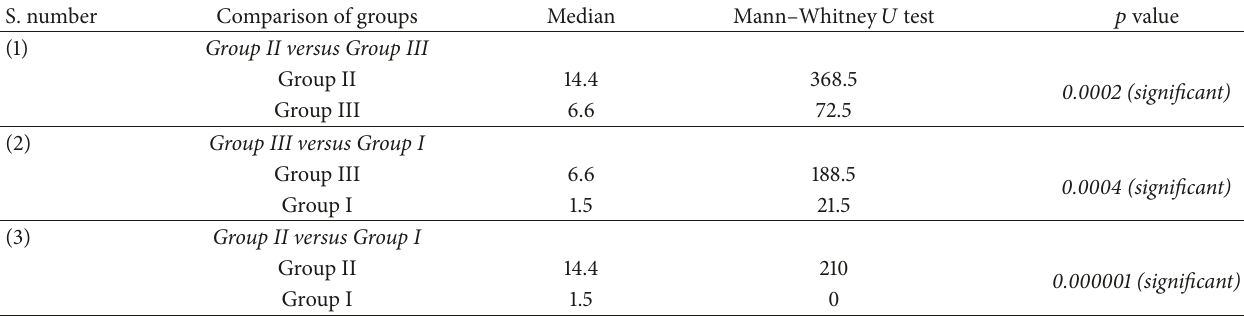
Table 3: Intergroup comparison of mast cell distribution using Mann–Whitney 𝑈